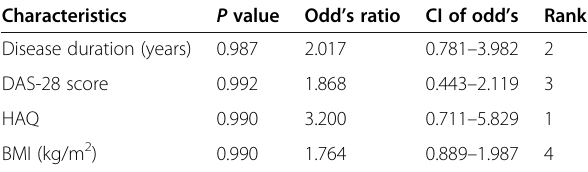
Table 4 Multivariate binary logistic regression analysis of the possible risk factors for neuropathic pain among RA patients